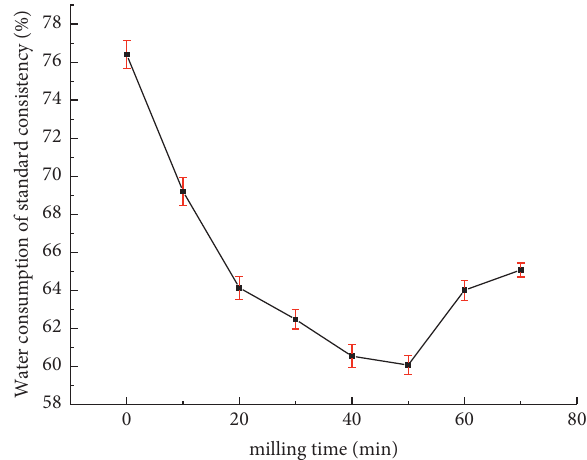
Figure 2: Trend of the water consumption of normal consistency.